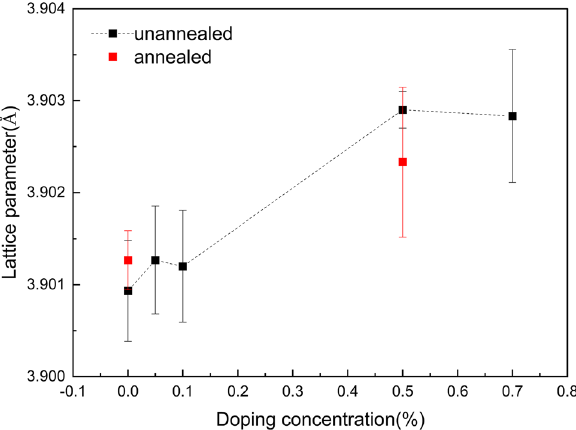
Figure 1. The out of plane lattice parameter c dependence of Nb-doping concentration in SrTiO 3